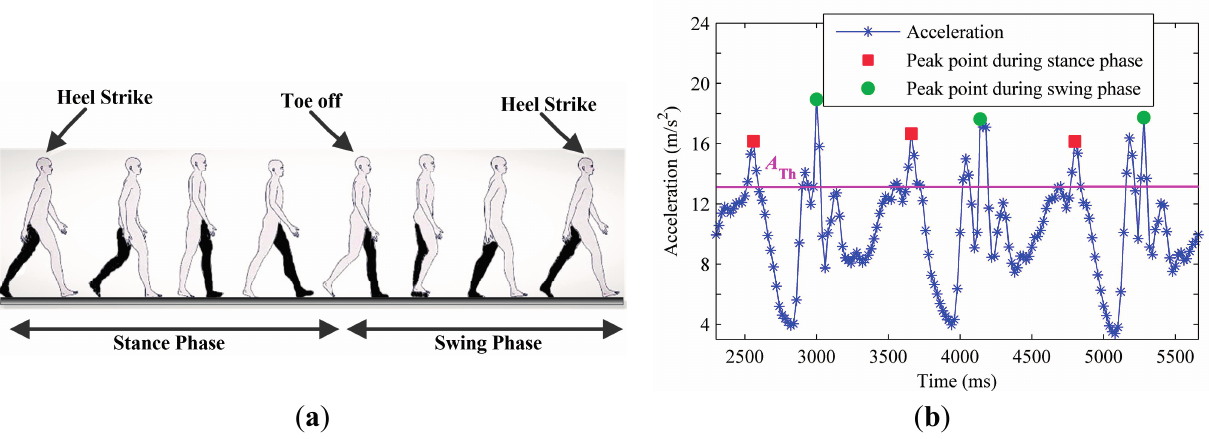
Figure 2. Acceleration patterns of pedestrian walking with the smartphone put in the pocket: ( a ) Walking cycle includes two phases: stance phase and swing phase; ( b ) The peak detection algorithm detects one stride with two footsteps (peak